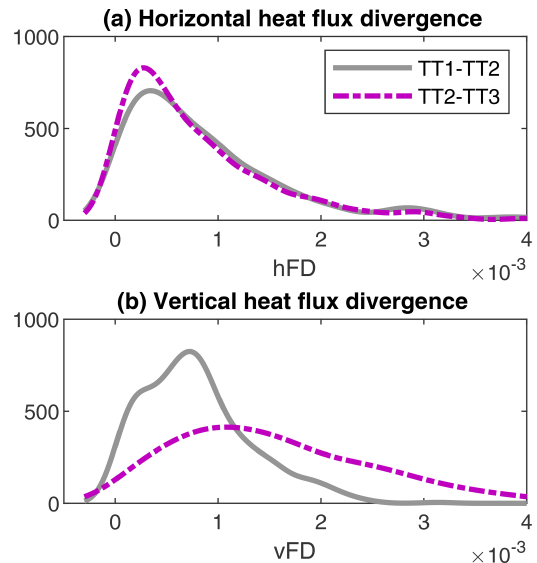
Figure 13. Kernel distribution of streamwise horizontal (hDF) and vertical (vDF) heat flux divergence shown only for disturbed condi- tions and the 60 ◦ wind sector (260–320 ◦